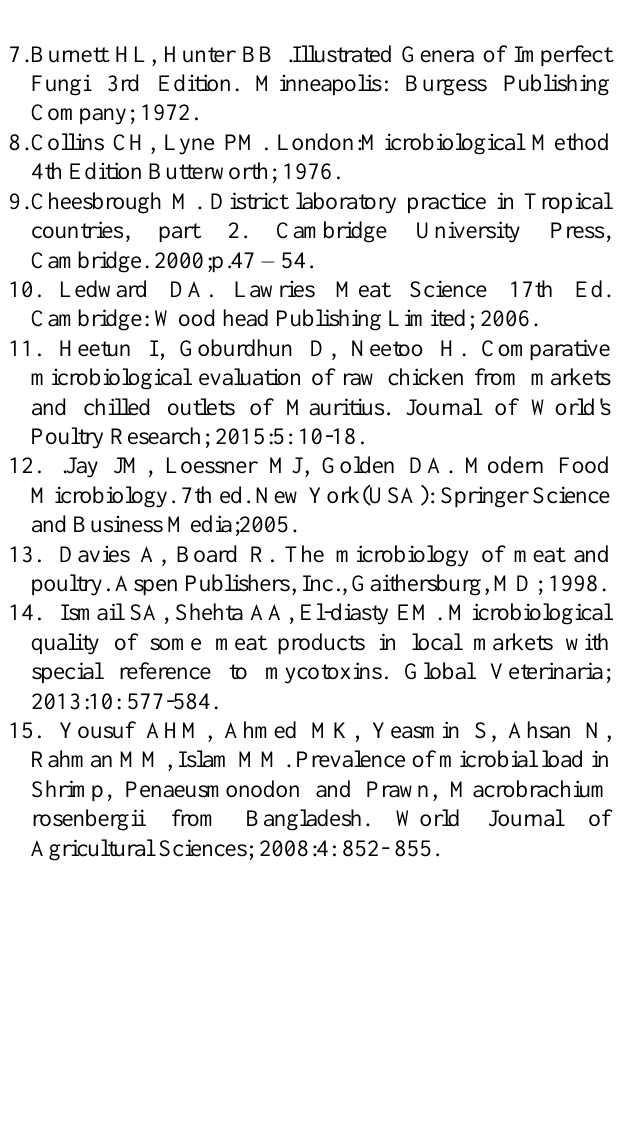
Table 6. Biochemical tests of bacterial isolates from roasted and fried meats (beef and chickens). Isolate Microscopy